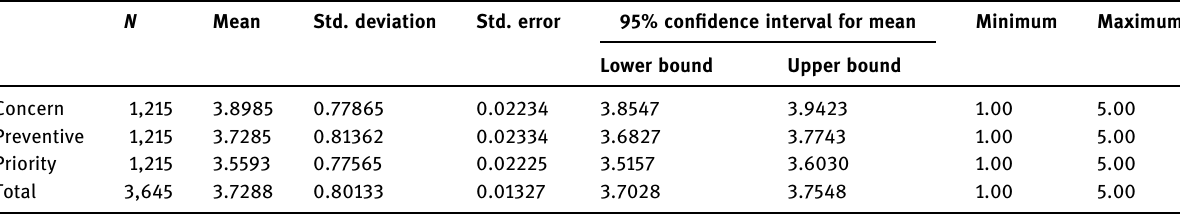
Table 23: Descriptive of awareness level by areas of expertise at VHS N